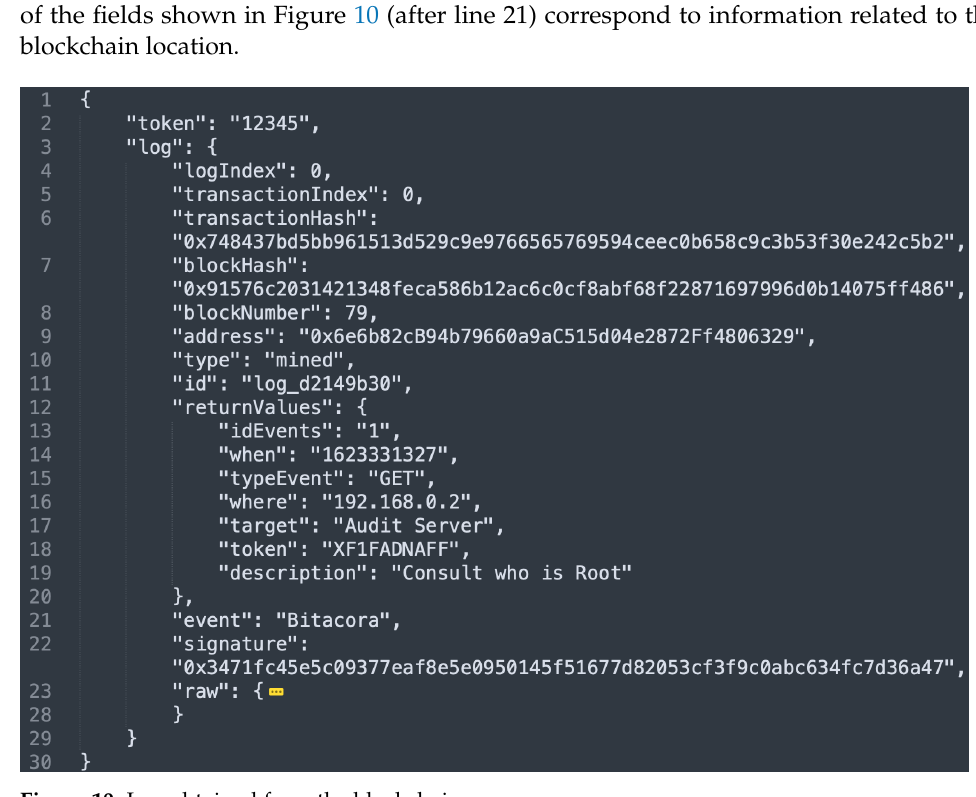
Figure 10. Log obtained from the